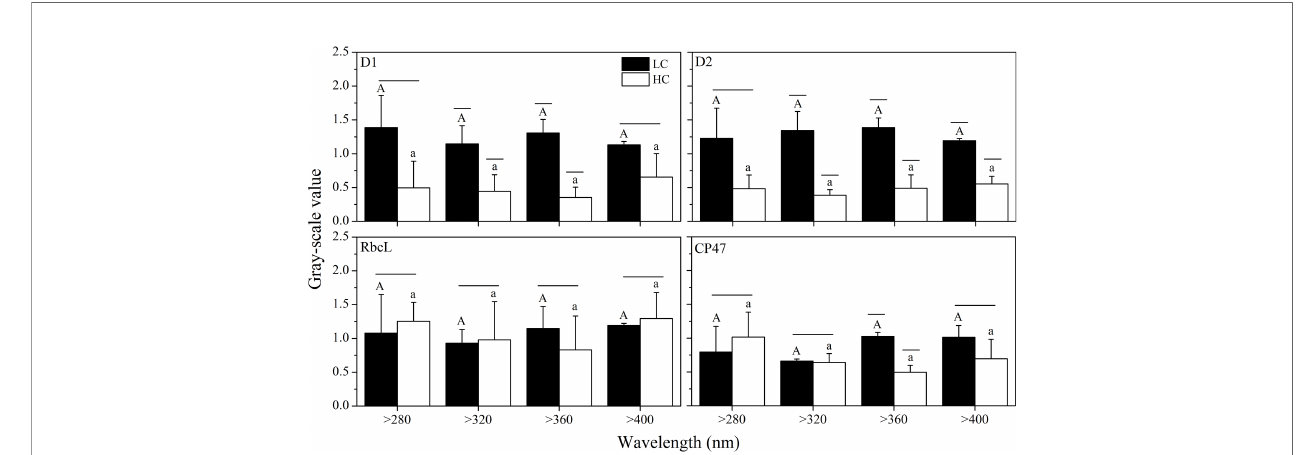
FIGURE 9 | Quantitative analysis of proteins of S. costatum acclimated to ambient (LC, black bars) and elevated CO 2 (HC, white bars) in different spectral treatments. The different uppercase and lowercase letters represent signi fi cant differences between different spectral treatments under LC and HC conditions,